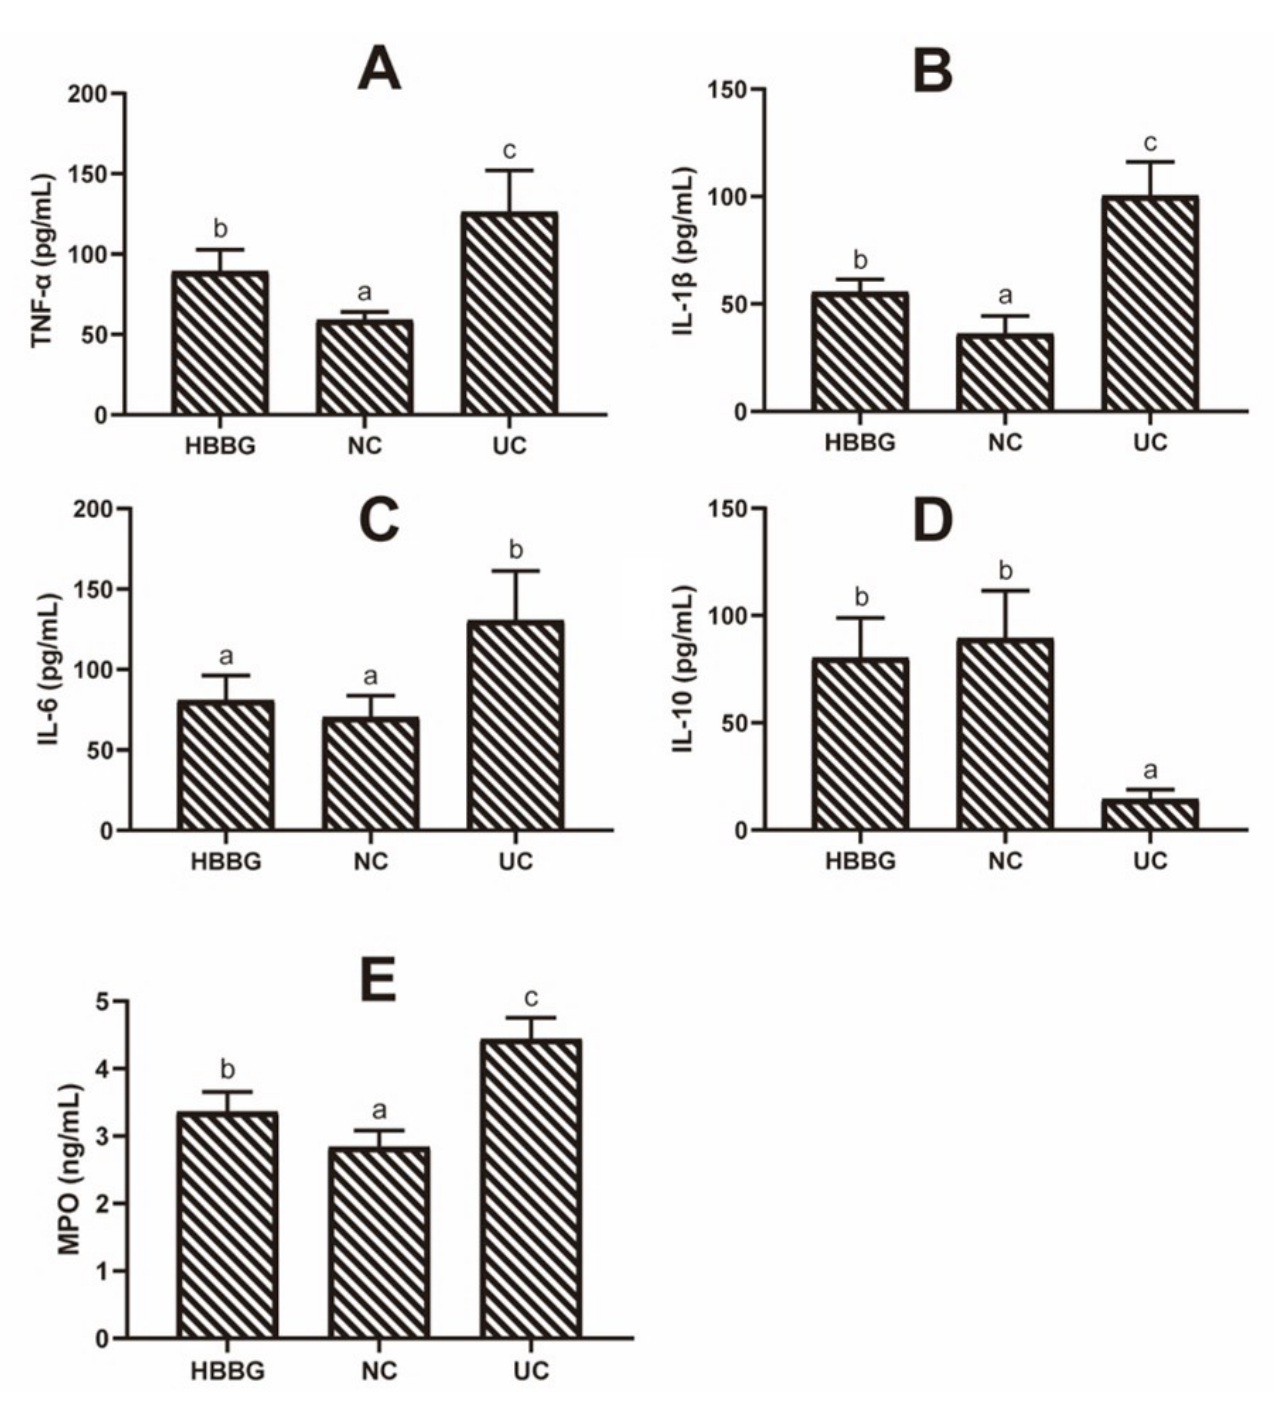
Figure 4. The effects of HBBG on serum inflammatory cytokines and MPO: ( A ) TNF- α ; ( B ) IL-1 β , ( C ) IL-6; ( D ) IL-10; ( E ) MPO. Different letters indicate statistically significant differences ( p < 0.05); on the contrary, the same letters indicate no statistically significant differences ( p >